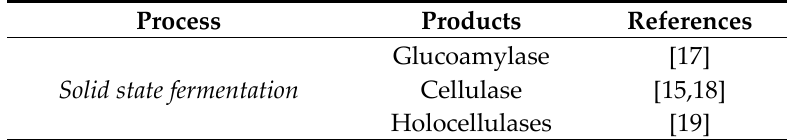
Table 1. Representative studies on enzyme extraction from organic fraction of municipal solid waste (OFMSW)-derived media.